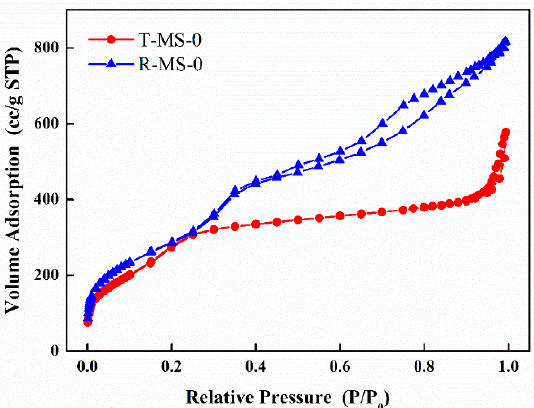
Figure 4. The nitrogen (N 2 ) adsorption–desorption isotherm curves of T-MS-0 and R-MS-0.